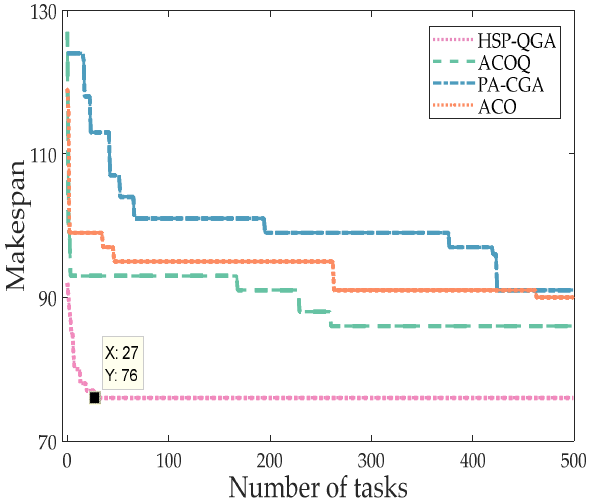
Figure 9. Comparison of convergence speed and scheduling